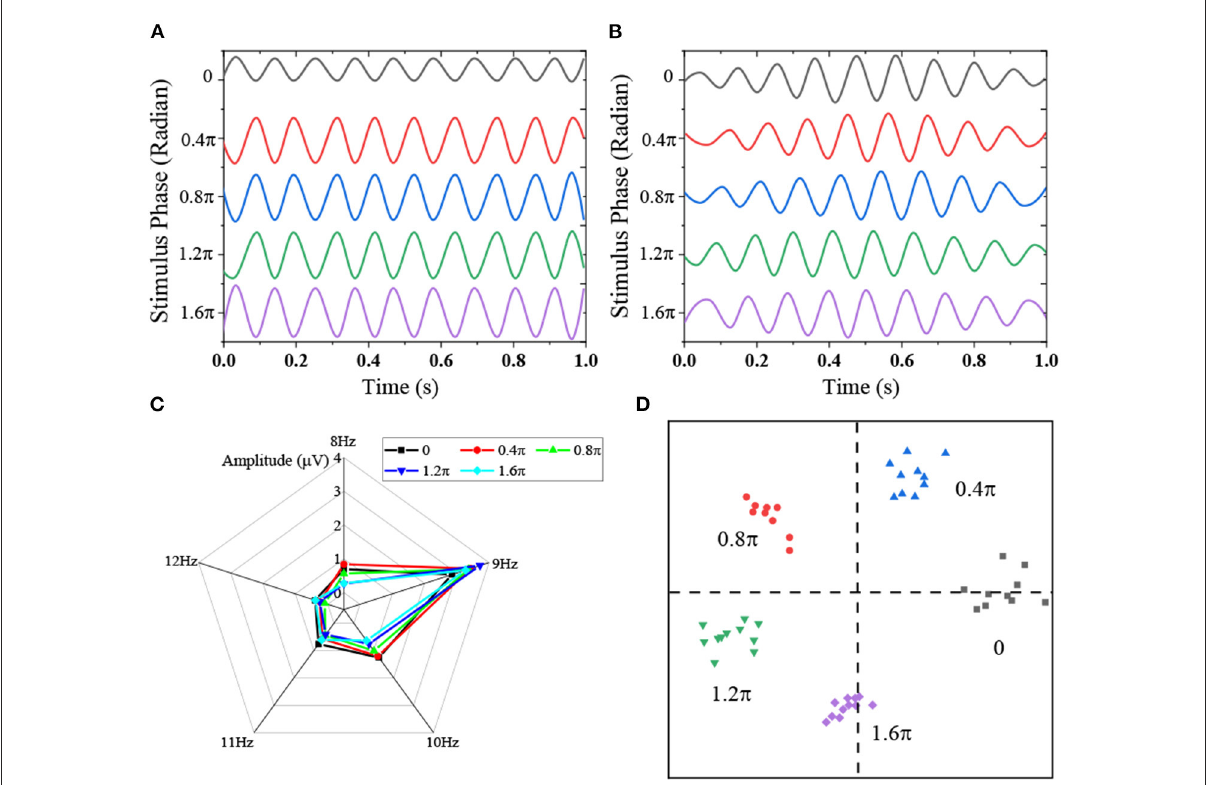
FIGURE8 Performance of online BCI system under hybrid frequency-phase coding with different data lengths [ (A) classification accuracy; (B) ITR].